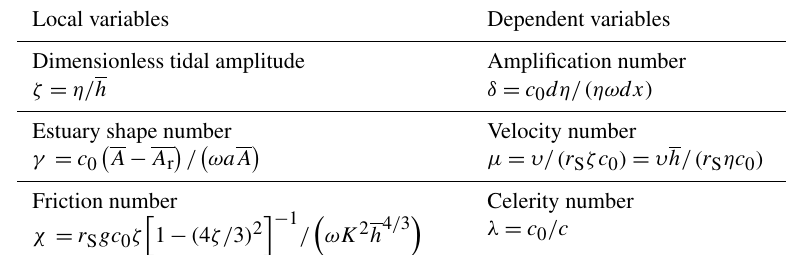
Table 1. Definitions of dimensionless parameters used in the analytical model.